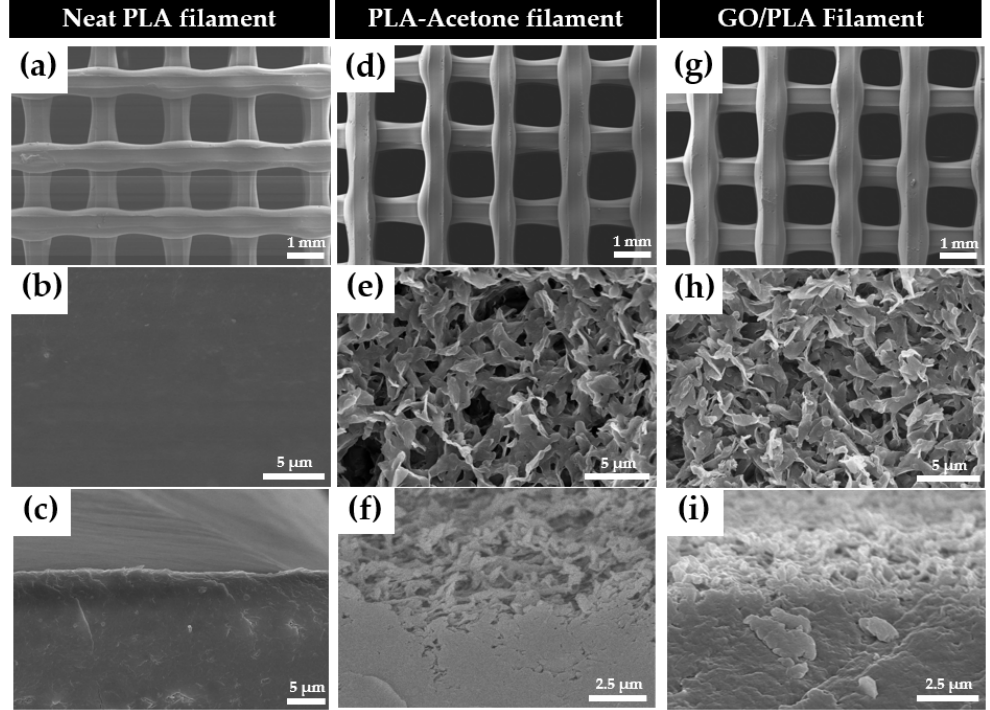
Figure 5. Surface morphologies of pure PLA filament ( a – c ), chemically etched PLA-acetone after acetone treatment ( d – f ), and GO/PLA ( g – i ). The bird eye view of filter ( a , d , g ), detailed view of surface ( b , e , h ), and detailed view of the cross-section of each filament ( c , f , i ) were provided. The GO/PLA filters prepared by following the optimized pre-treatment process (i.e., 95% acetone, 0 min drying time) were used to determine the characteristics of GO by means of FTIR and Raman spectroscopy. Figure 6a shows the infrared spectra of PLA, PLA-acetone, PLA-acetone-GO (GO/PLA), and GO. The peak assignments of neat PLA